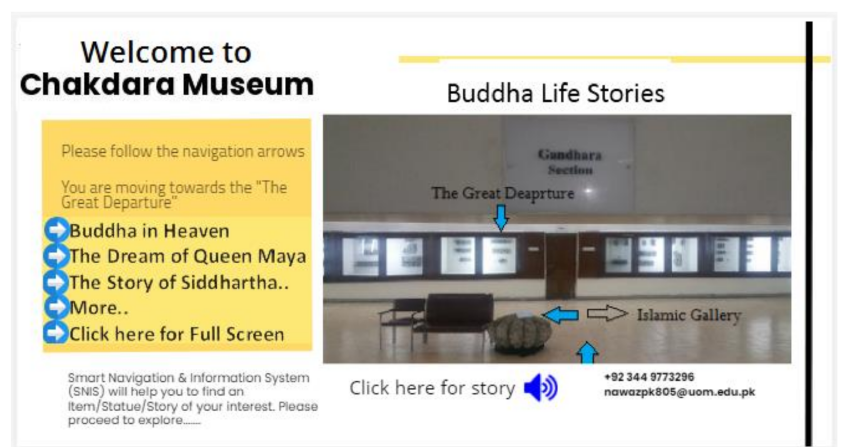
Figure 13. Navigation toward the proper